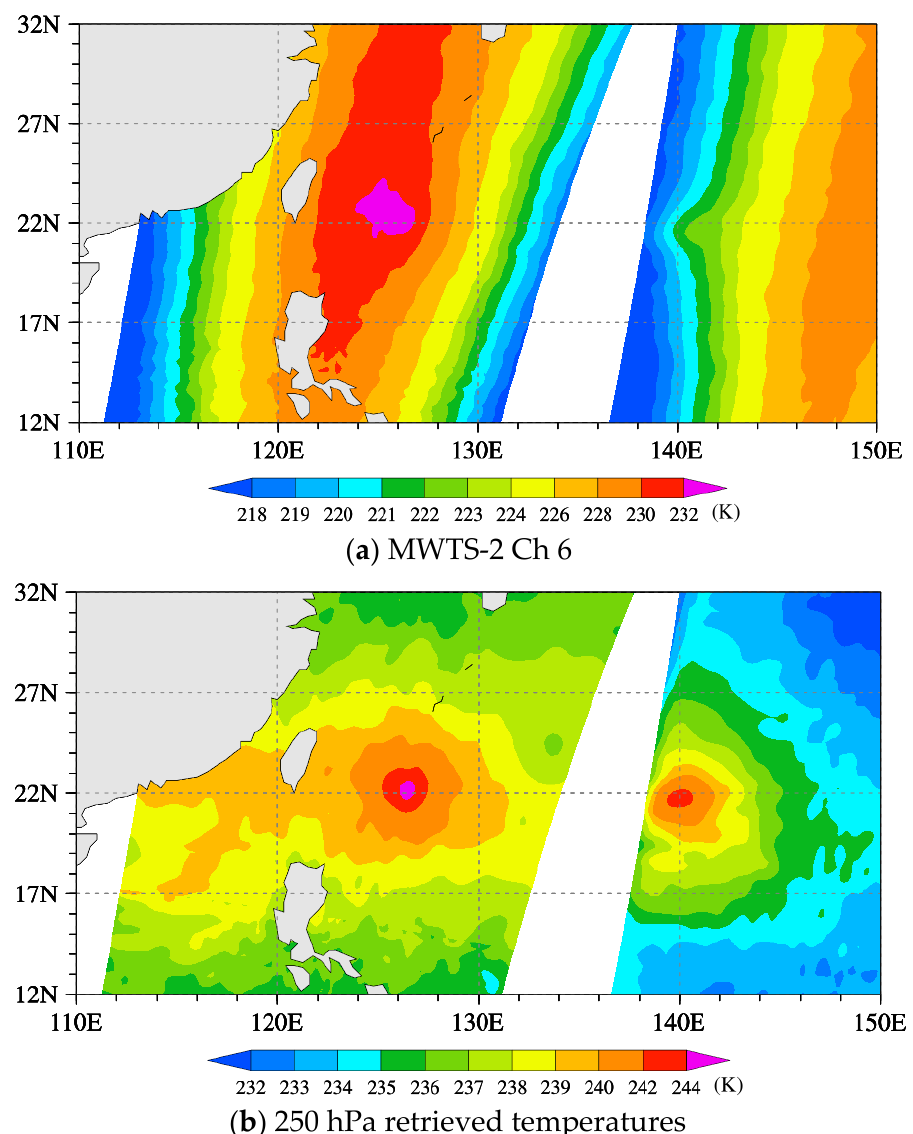
Figure 7. Spatial distribution of ( a ) MWTS-2 brightness temperature observations at channel 6 and ( b ) 250 hPa retrieved temperatures at the FY-3D descending node within and around Typhoons Lekima located at (126.5 ◦ E, 22.1 ◦ N) at 1724 UTC and Krosa located at (140.2 ◦ E, 22.4 ◦ N) at 1545 UTC on 7 August 2019.